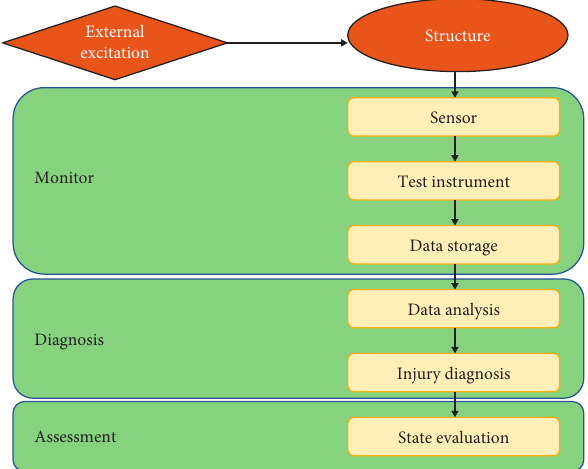
Figure 1: Overview of